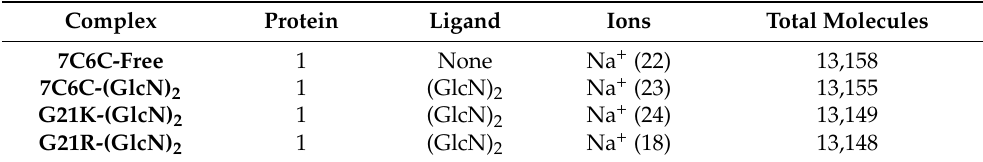
Table 3. Details corresponding to the four systems.